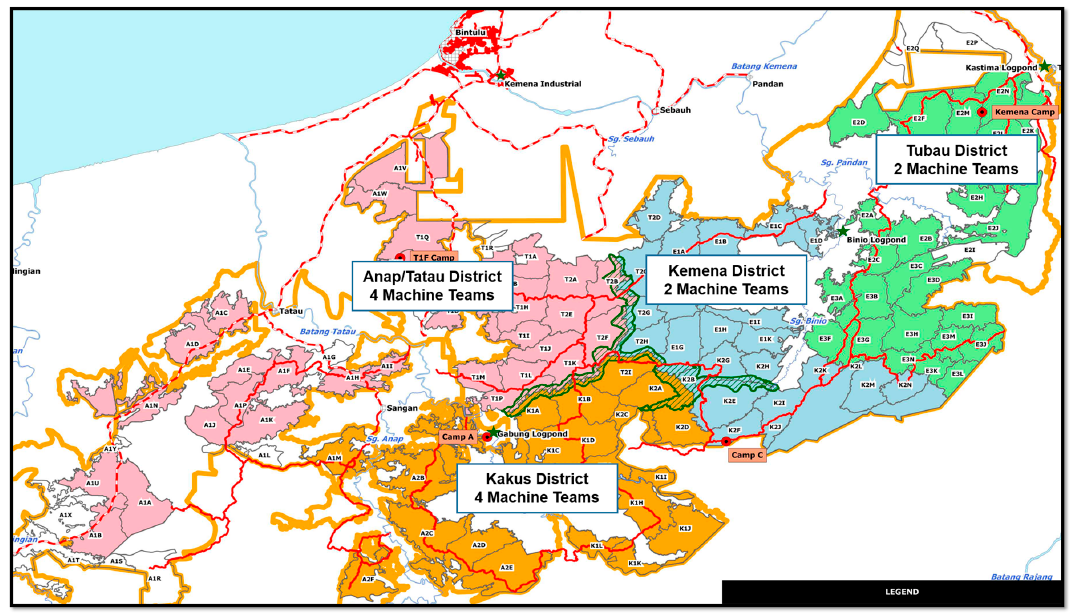
Figure 3. Position of the study compartments and of the 12 machine teams involved with the study.